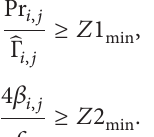
Figure 5: Power spectrum and range resolution of the received signals in 𝑆 4 collected by the harmonic step-frequency radar measurement